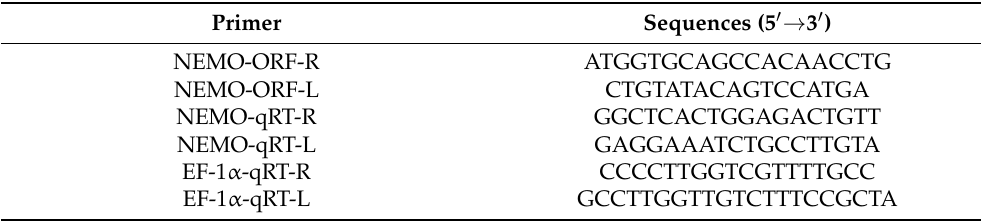
Table 1. Information regarding the NEMO primers used in this